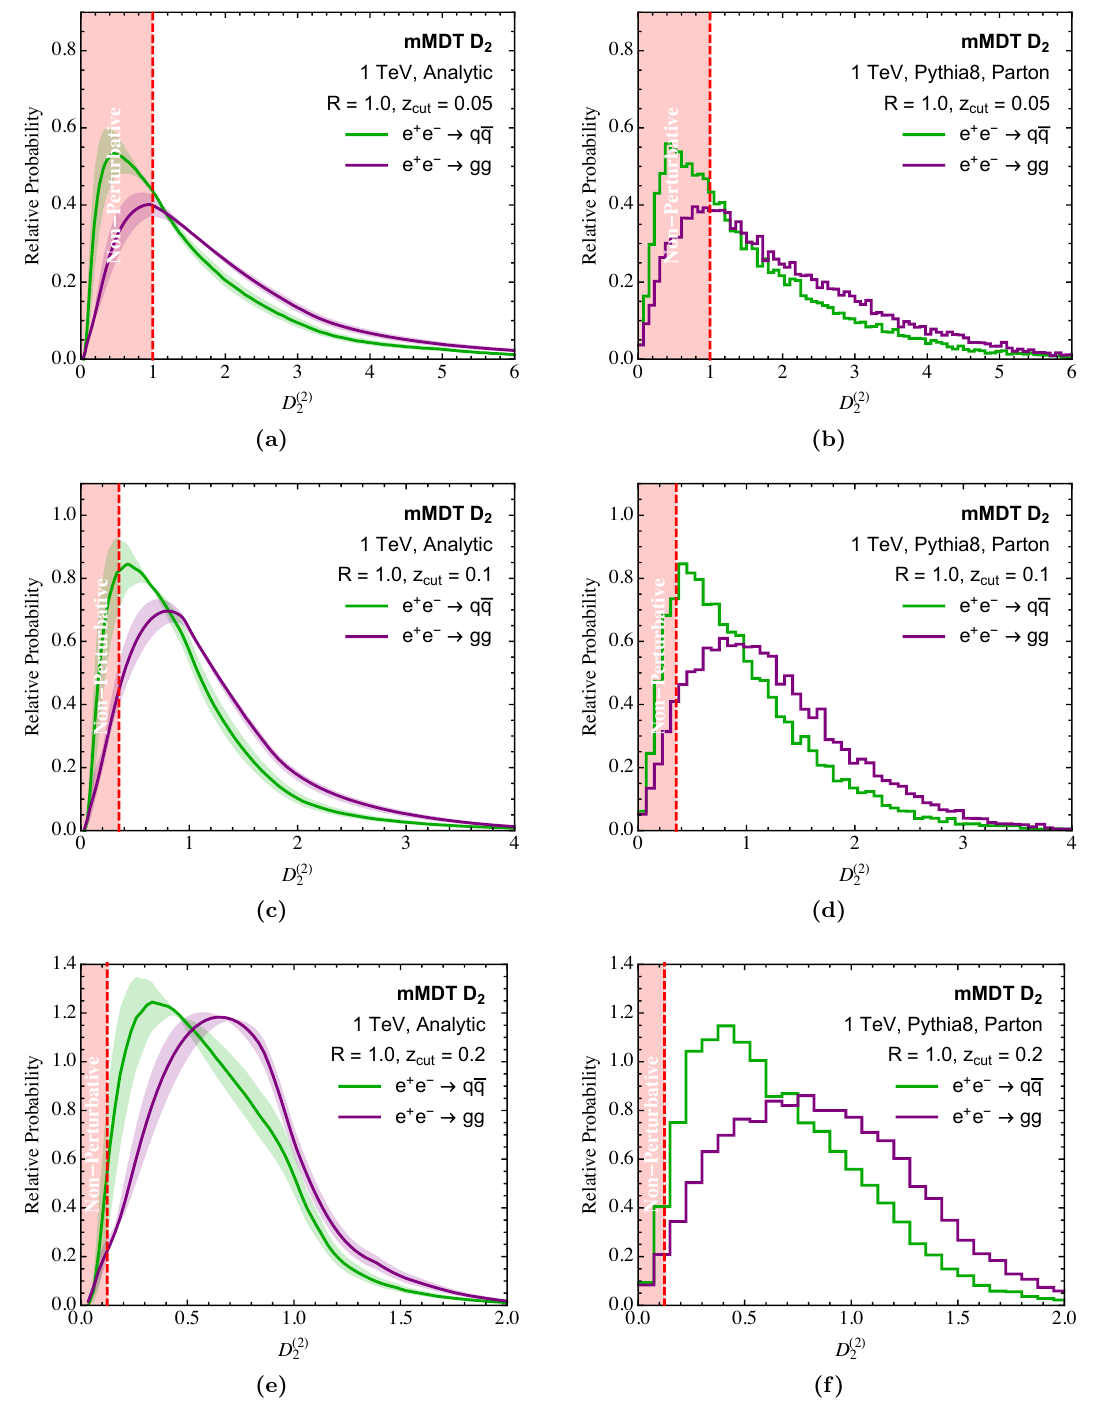
Figure 13. A comparison of the analytic D (2) distributions for both quark and gluons (left 2 column) with parton shower Monte Carlo at parton level (right column), for di(cid:11)erent values of the z cut parameter. A mass cut of m J [80 ; 100] GeV has been applied. Good agreement in the shape 2 is observed, particularly for smaller values of z cut .